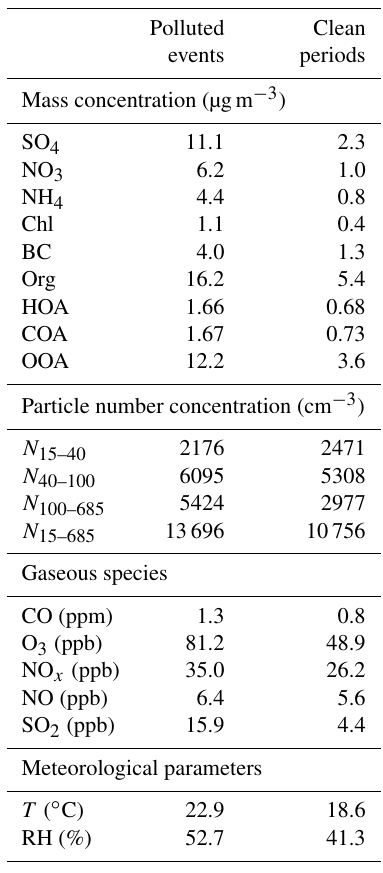
Table 1. Comparison of aerosol properties and meteorological pa- rameters between polluted events and clean